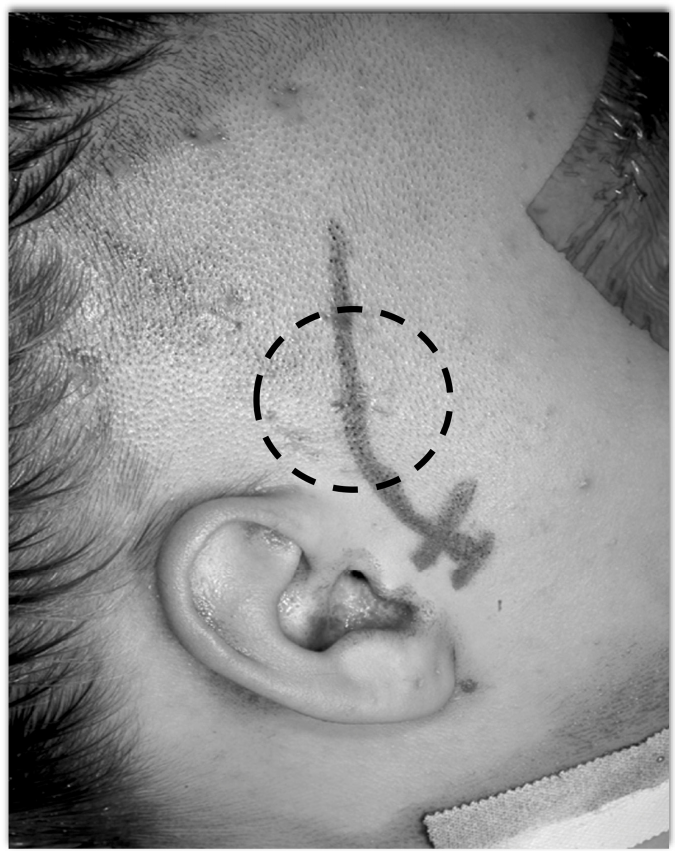
Figure 10. The keyhole minimal access approach benefits the patient with smaller skin incision and cranial opening. A slight curve in the scalp incision helps exposure and reduces retraction forces on the temporalis muscle compared with a straight linear incision.